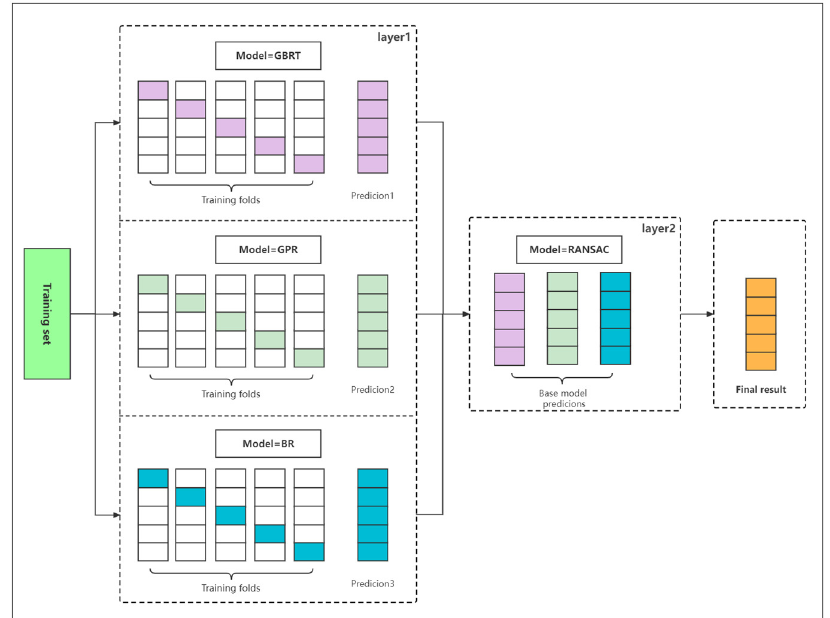
Figure 3. The stacking ensemble learning framework of this study. The first layer (the base-level learning component) consists of a gradient boosting regression tree (GBRT), a gaussian process regression (GPR), and a bagging regression (BR). The second layer (meta-level combining component) consists of random-sample consensus (RANSAC) regression.